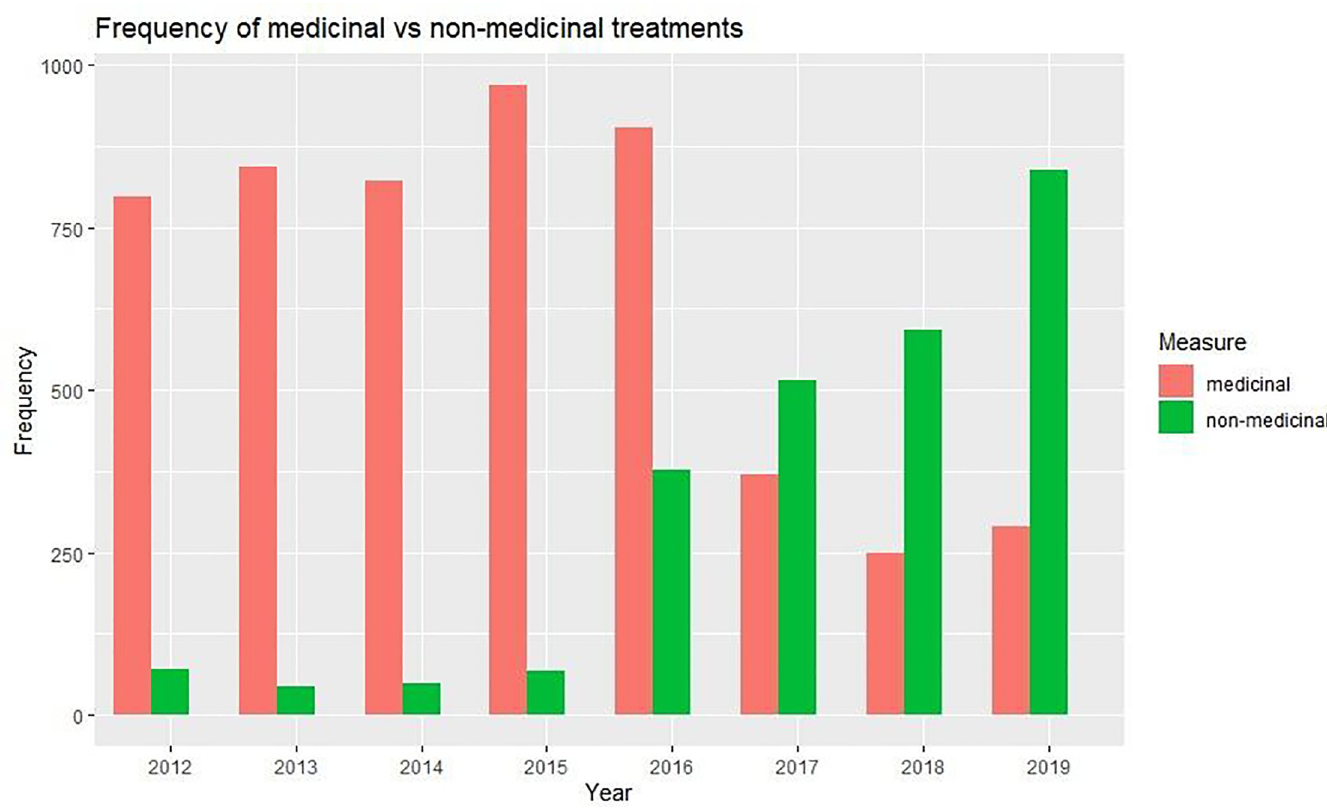
Fig 4. Medicinal versus non-medicinal treatments per